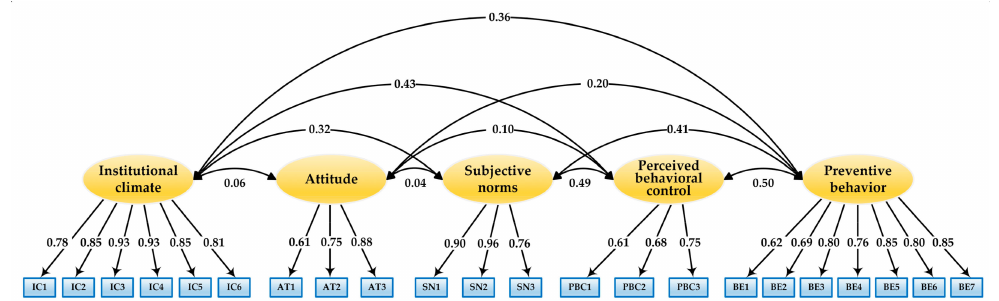
Figure 2. Results of the CFA.